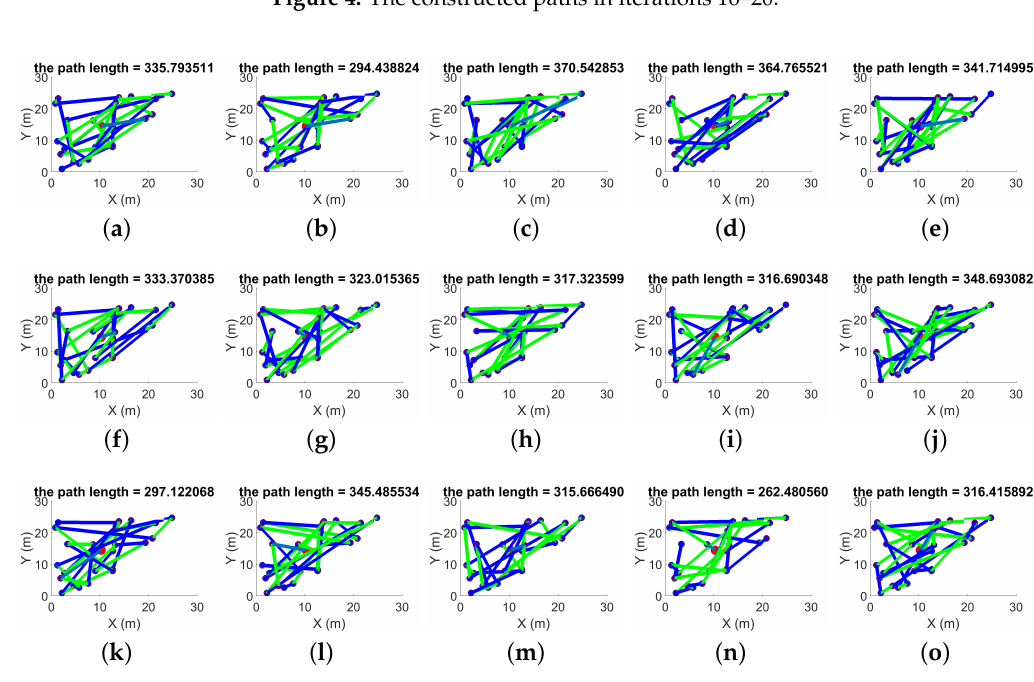
Figure 5. The constructed paths in iterations